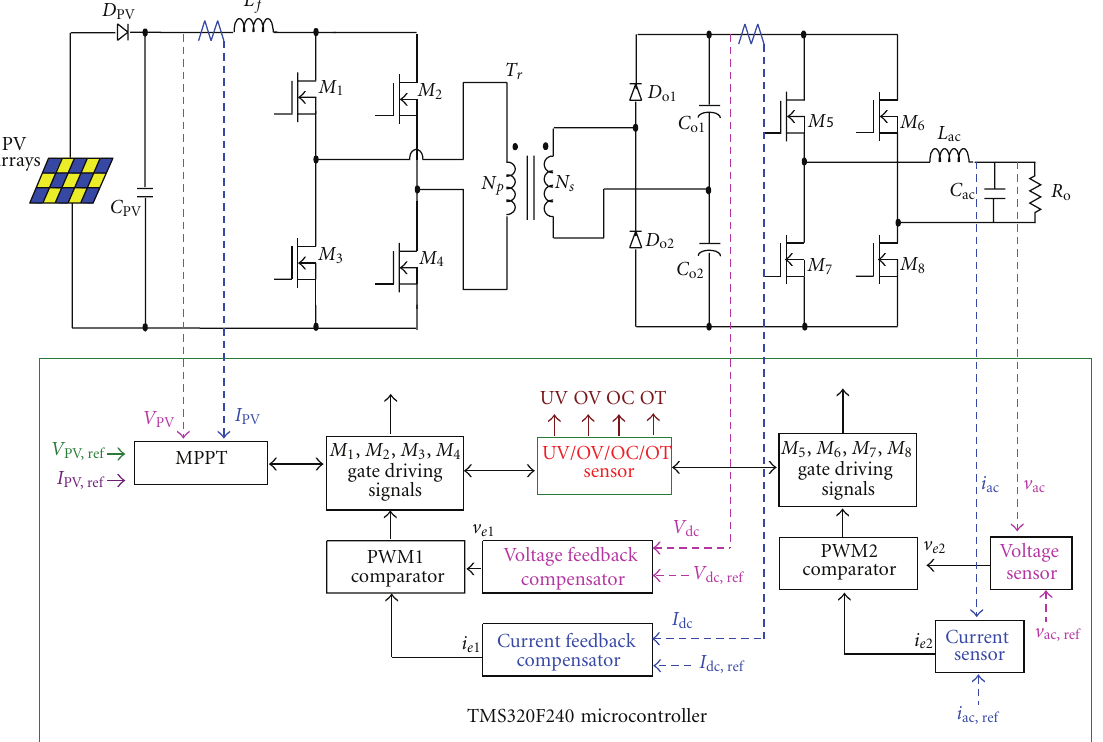
Figure 8: Conceptual control block diagram of the proposed PV power-generation